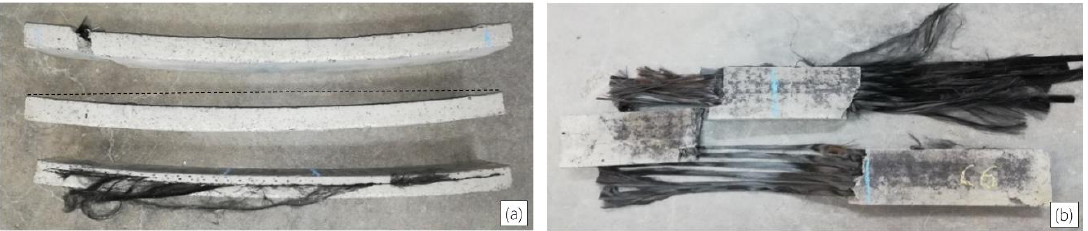
Figure 11. ( a ) Curvature of specimens from the one-sided fire loading and the asymmetrical placement of the reinforcement; ( b ) specimen in Series C that was subjected to fire testing. The fibers were easily pulled out by hand after the flexural test of the specimen.